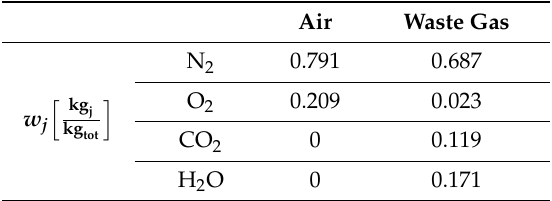
Table 1. Air and exhaust gases chemicals mass concentration